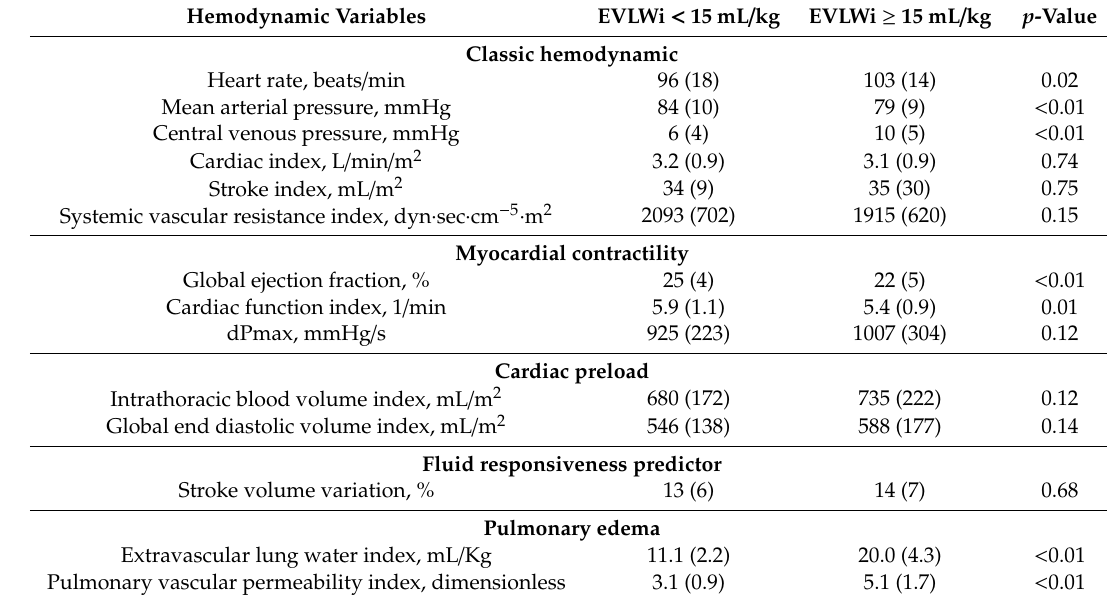
Table 4. Dichotomic analysis of transpulmonary thermodilution (TPTD) measurements according to extravascular lung water index (EVLWi) with a threshold of 15 mL / Kg. dPmax is the maximal change of arterial pressure per second. Values are mean with standard deviation (SD) in parenthesis. Comparisons were made using the